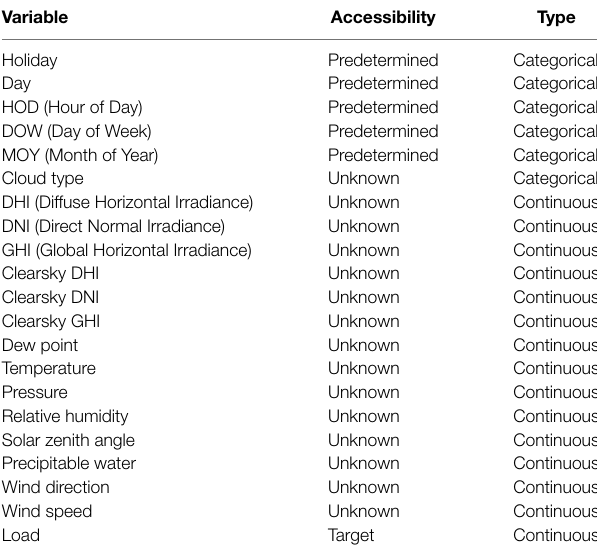
TABLE 2 | Feature and target specification in the UTD dataset. Variable